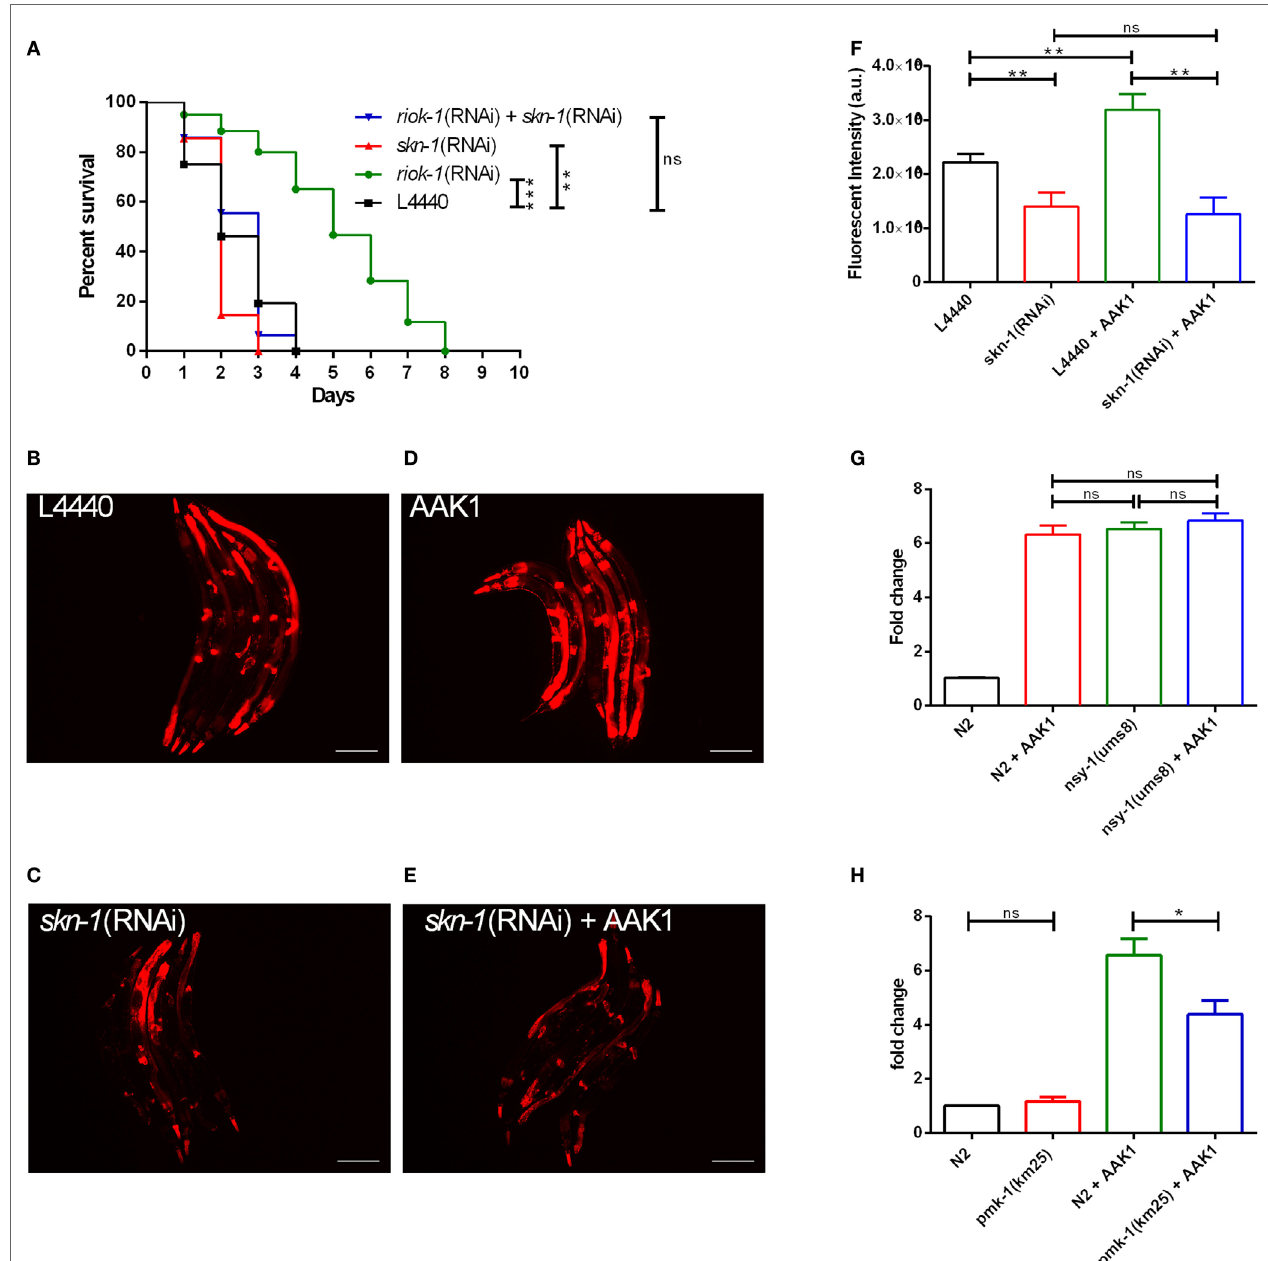
FigUre 5 | The increase in riok-1 is skn-1 -dependent in Caenorhabditis elegans with Aeromonas dhakensis infection. (a) Single knockdown of skn-1 or simultaneous knockdown of skn-1 and riok-1 resulted in a decrease in the life span in C. elegans with A. dhakensis infection. (B) riok-1 expression in riok-1 transcriptional reporter worms with RNAi control vector L4440. (c) riok-1 expression in riok-1 transcriptional reporter worms with RNAi knockdown of skn-1 . (D) riok-1 expression in riok-1 transcriptional reporter worms with A. dhakensis AAK1 infection. (e) riok-1 expression in riok-1 transcriptional reporter worms with RNAi knockdown of skn-1 and A. dhakensis AAK1 infection. (F) A summary of the florescence quantification of (B–e) . (g) The expression level of riok-1 as determined using quantitative real time-PCR (qRT-PCR) in the p38 gain-of-function-mutant worms nsy-1(ums8 ) with and without A. dhakensis AAK1 infection was similar to those in wild-type N2 worms with A. dhakensis AAK1 infection. (h) The expression levels of riok-1 as determined using qRT-PCR in the p38 MAPK/ pmk-1 - mutant worms pmk-1(km25) with A. dhakensis AAK1 infection were lower than in wild-type N2 worms with A. dhakensis AAK1 infection. The scale bars in (B–e) are all 100 µm. *** P < 0.001, ** P < 0.01, and * P < 0.05.